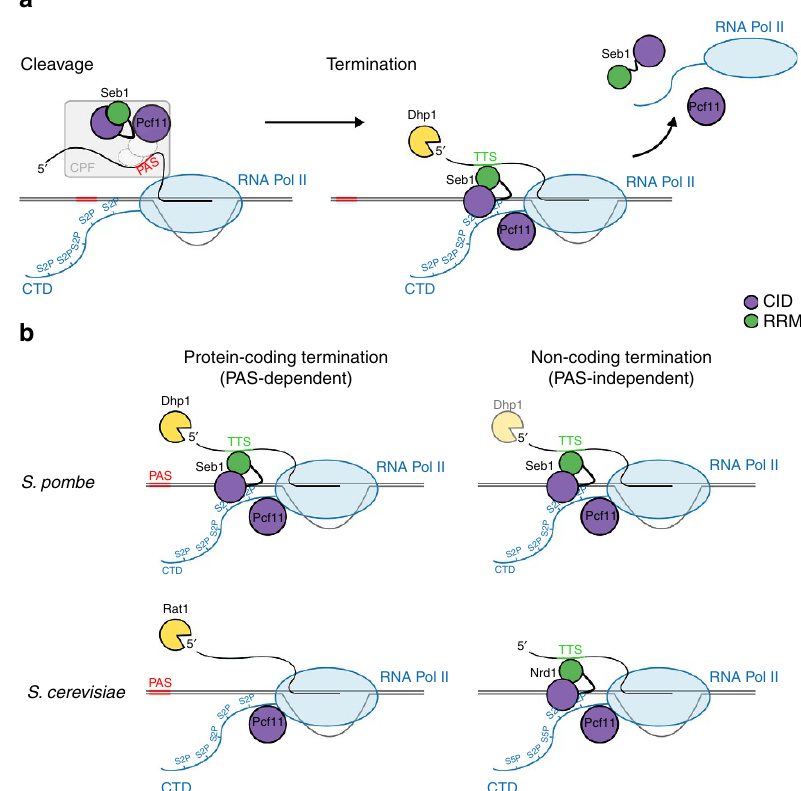
Figure 6 | Model for the function of Seb1 and Pcf11 in transcription termination. ( a ) A proposed model for 3 0 end formation and transcription termination that relies on the cooperative action of the CID-proteins Seb1 and Pcf11. Seb1 and Pcf11 are recruited to the 3 0 ends through interaction with components of the CPF complex. During transcript cleavage by the CPF/CF, Pol II is phosphorylated on S2 which allows direct CTD interaction of Seb1 and Pcf11. In addition, the Seb1 binding motif, which serves as a termination signal (TTS), is transcribed allowing for Seb1 interaction with the nascent transcript via its RRM domain. Seb1 and Pcf11, probably together with the exonuclease Dhp1, lead to the disassembly of the Pol II complex from the DNA template. ( b ) Fission yeast utilize a conserved mechanism for termination of the PAS-dependent (protein-coding) and PAS-independent (non-coding) genes. This is in contrast to budding yeast which relies on two different mechanisms for termination. In fission yeast, Seb1 and Pcf11 are necessary for termination of Pol II on both classes of genes. In budding yeast, protein-coding genes are terminated by Pcf11 and Rat1, whereas non-coding transcripts are terminated by Nrd1. Pcf11 is involved in termination of all Pol II transcribed genes in both